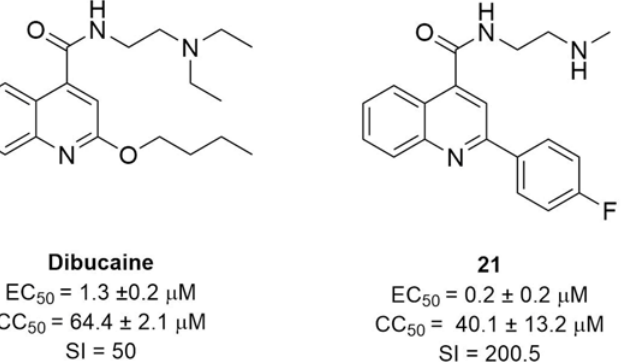
Figure 12. Chemical structures, EC 50 , CC 50 and SIs against CV-B3 in Vero cells of dibucaine and its analogue 21 .